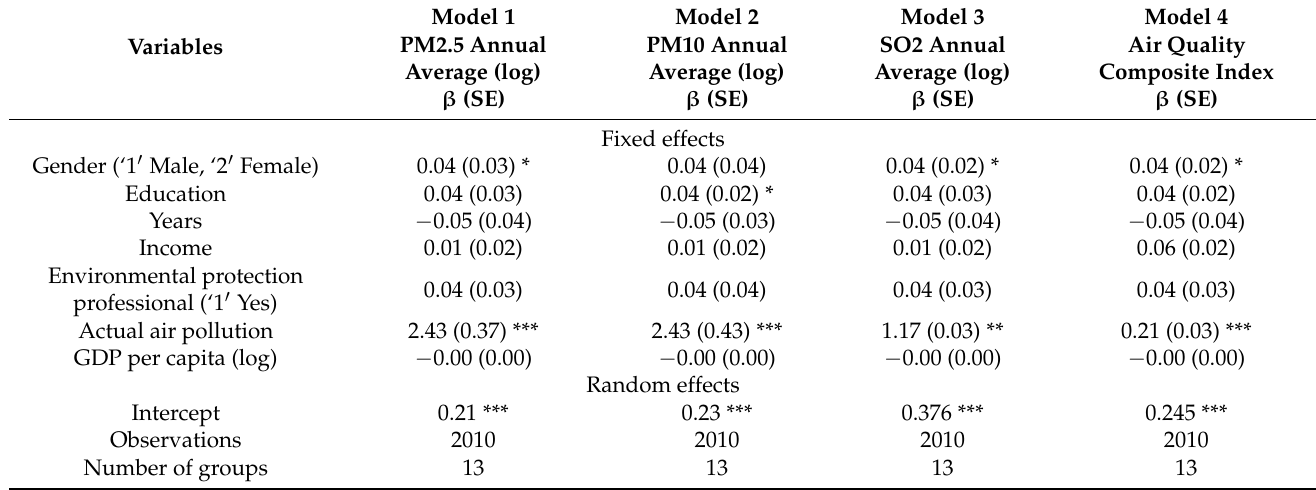
Table 1. The influence of demographic and actual air pollution variables on air pollution risk